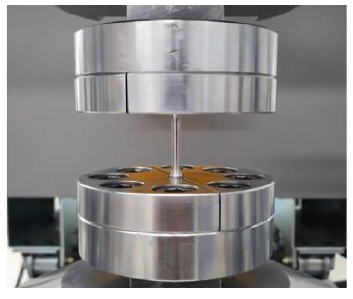
Figure 13. Fatigue test machine.